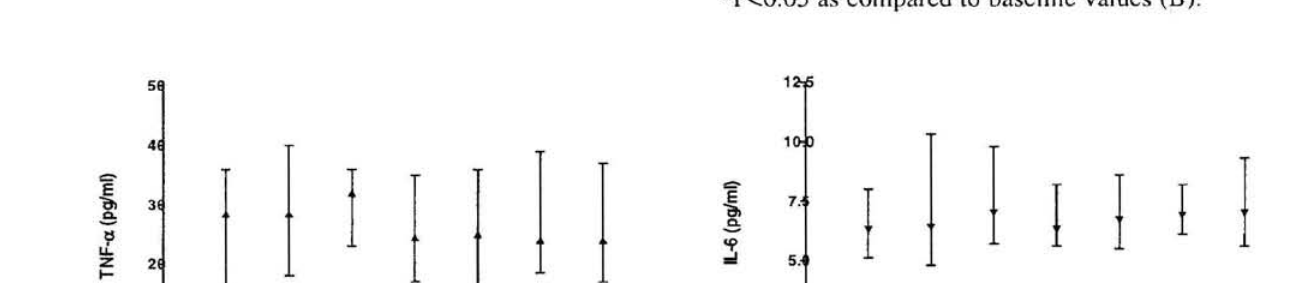
Figure 3. Time course of changes in soluble 75kD- type tumor necrosis factor-receptor (sTNF-R75) serum concentrations (ng/ml) in 22 male subjects with meta- bolic Syndrome before (B), during day 1 (AI), day 4 (A2), day 9 (A3), and day 19 (A4), and after sojourn at moderate altitude (1700 m above sea-level) as well as post-altitude I week (Rt) and 6-7 weeks (R2) follow- ing return to 500m above sea-level. Values are shown as medians with the 25"' and the 75"' percentile. *P<0.05 as compared to baseline values (B).